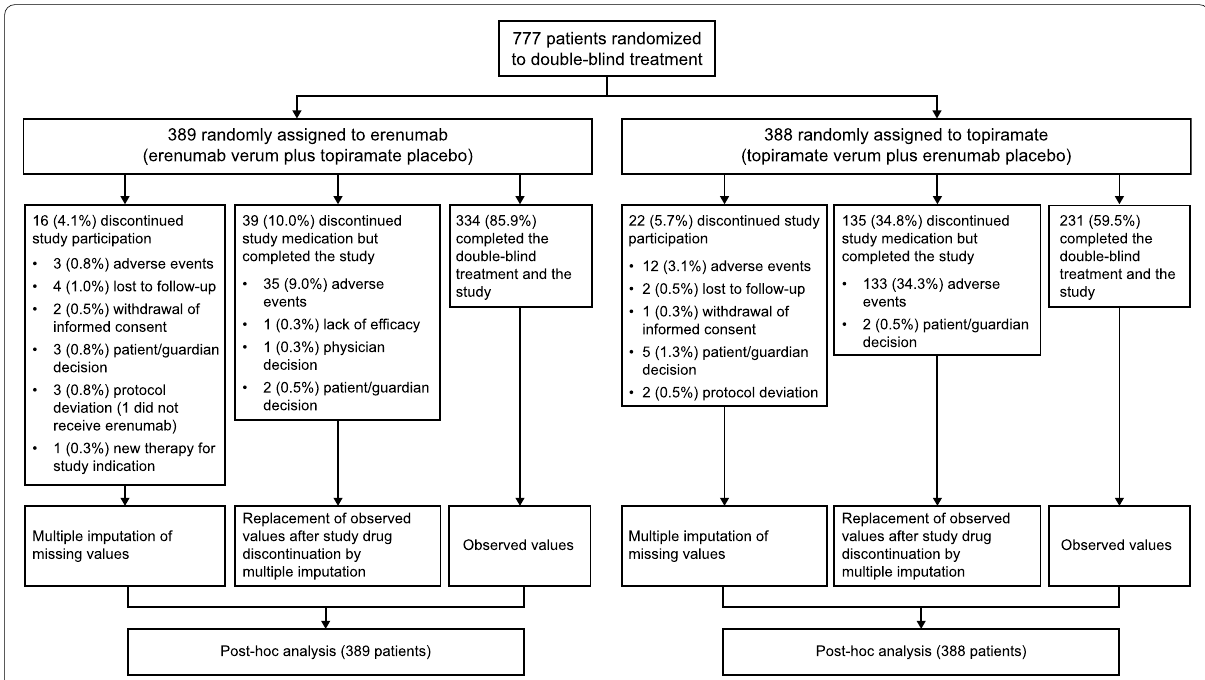
Fig. 1 Treatment assignment, reasons for discontinuation and patients included in post hoc